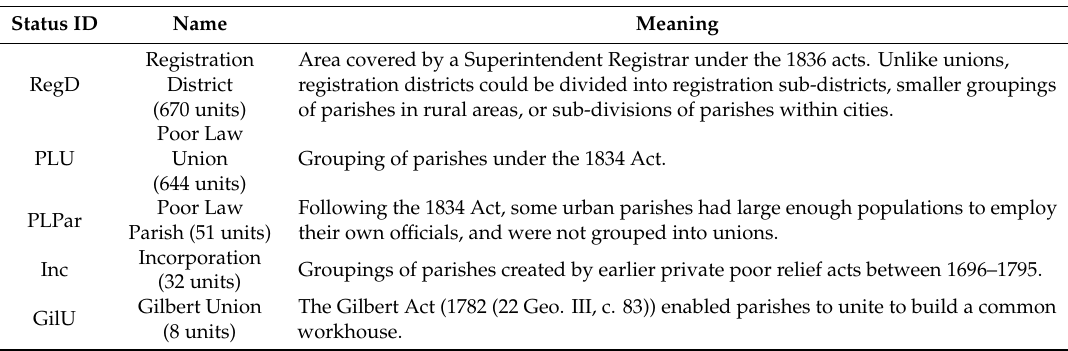
Table 1. Status values defined for unit type